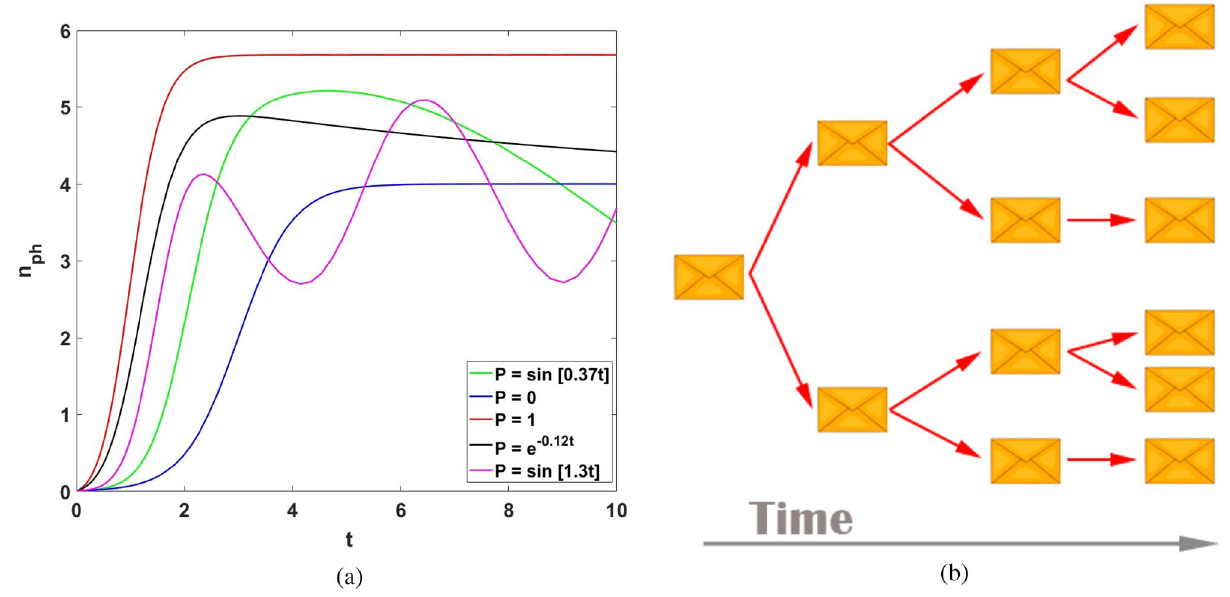
0.25 . Pump rates are: 1 and B Figure 4. ( a ) Time dependence of average s-photon number n ph ( t ) for A = = 0 (blue curve), P 1 (red curve), P ( t ) P sin ( 0.37 t ) (green curve), P ( t ) sin ( 1.3 t ) (magenda curve), and = = = = P ( t ) e − 0.12 t (black curve), respectively. ( b ) Viral Information cascade in solaser network. The cascade starts = with a socially stimulated repost (retweet) in the presence of spontaneously posted message, which together deliver information to two other agents in the network and initiate new “spontaneously” or socially stimulated messages. The messages occur in accordance with the rules explained in Fig.